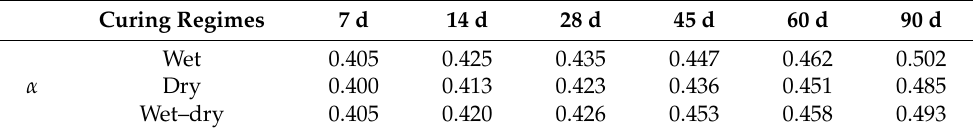
Table 3. The degree of hydration calculated by Equations (3) and (4).